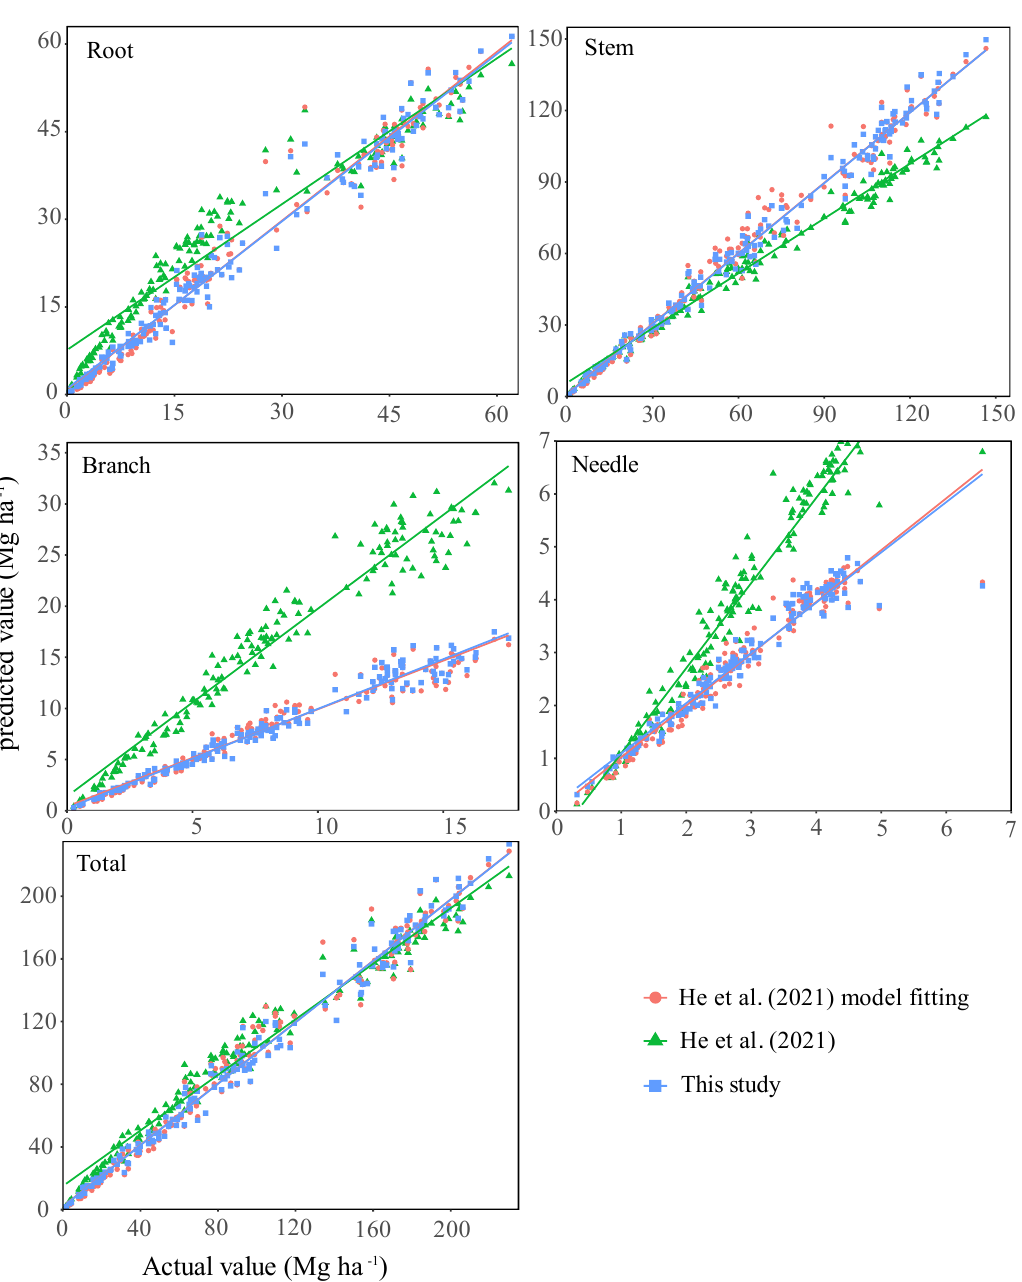
Figure 4. Scatter plots of the actual and predicted values calculated using the comparison of the proposed stand-level biomass climate-based model of this study (M-4) and the climate-sensitive model type II (CSM-II) by He et al. [72]; the predicted value obtained by fitting our data using his model form denoted by “He et al. (2021) model fitting” (orange dots), the predicted value obtained by substituting our data into his model and using his model parameters denoted by “He et al. (2021)” (green triangles), and the predicted value obtained by the model form used in this study denoted by “This study” (blue rectangles). The red, green, and blue lines are the regression lines of the actual and predicted